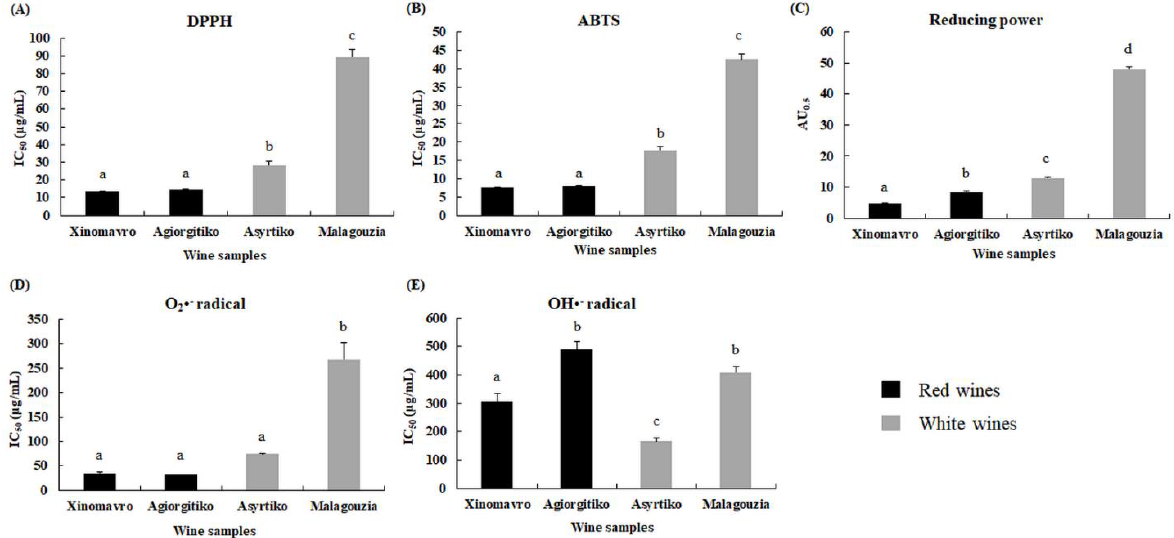
Figure 3. Antioxidant capacity of Greek wine extracts in in vitro assays. Results are expressed as mean ± SD. a–d: means without a common letter depict significant difference ( p < 0.05).